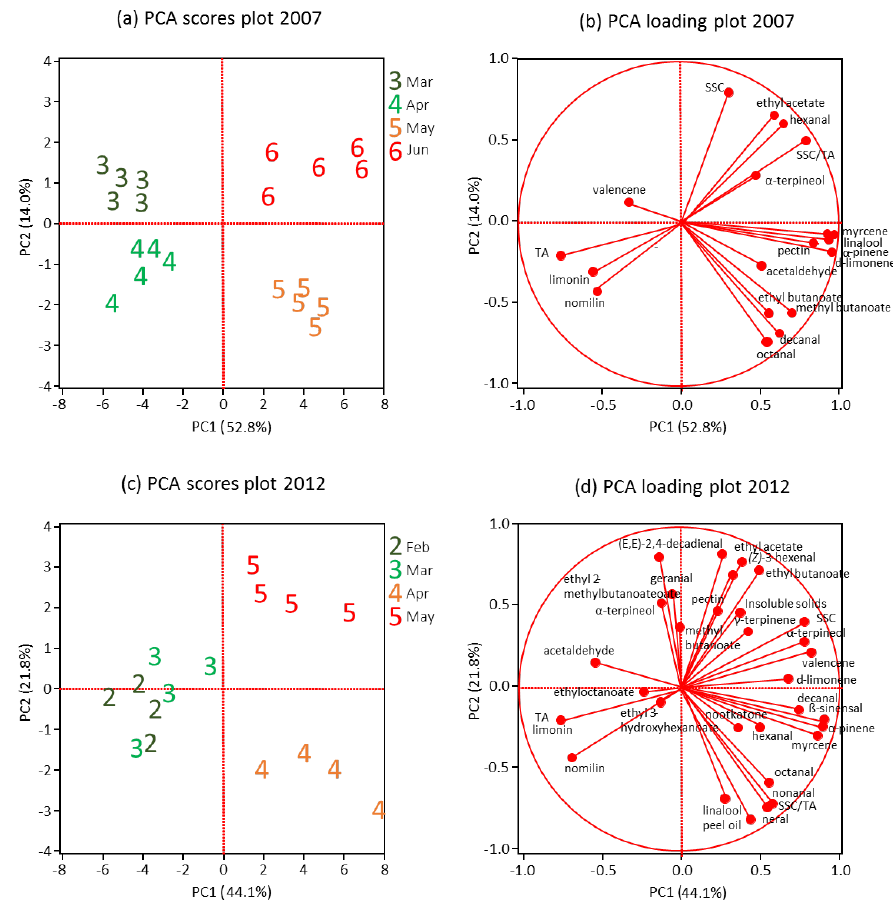
Figure 3. Principle component analysis (PCA) of important attributes of aroma, taste, and mouth feel components of Valencia’ orange juice harvested over the 2007 and 2012 seasons. ( a ) and ( b ) PCA scores plot and loading plot in 2007, respectively. ( c ) and ( d ) PCA scores plot and loading plot in 2012, respectively. Component numbers for volatile, non-volatile and mouth feel attributes were 13, 5 and 1, respectively in 2007 and 23, 5, and 3, respectively in 2012.